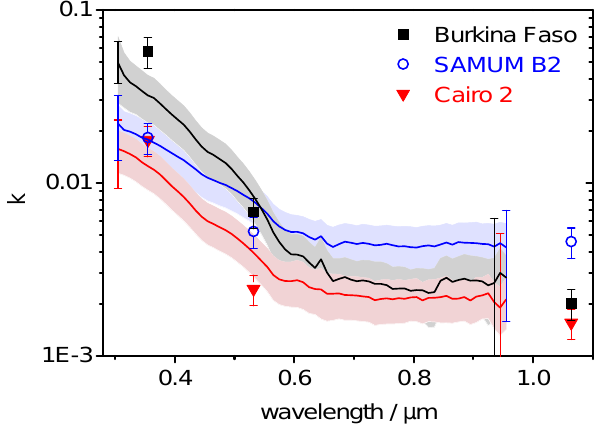
Fig. 11. Comparison of the k retrievals from the SOAP (lines) and 4 λ -PAS (symbols) absorption measurements for dispersed dust par- ticles from the Burkina Faso, SAMUM B2, and Cairo 2 soil sam- ples. Shaded areas and error bars denote various uncertainty esti- mates that are discussed in detail in the